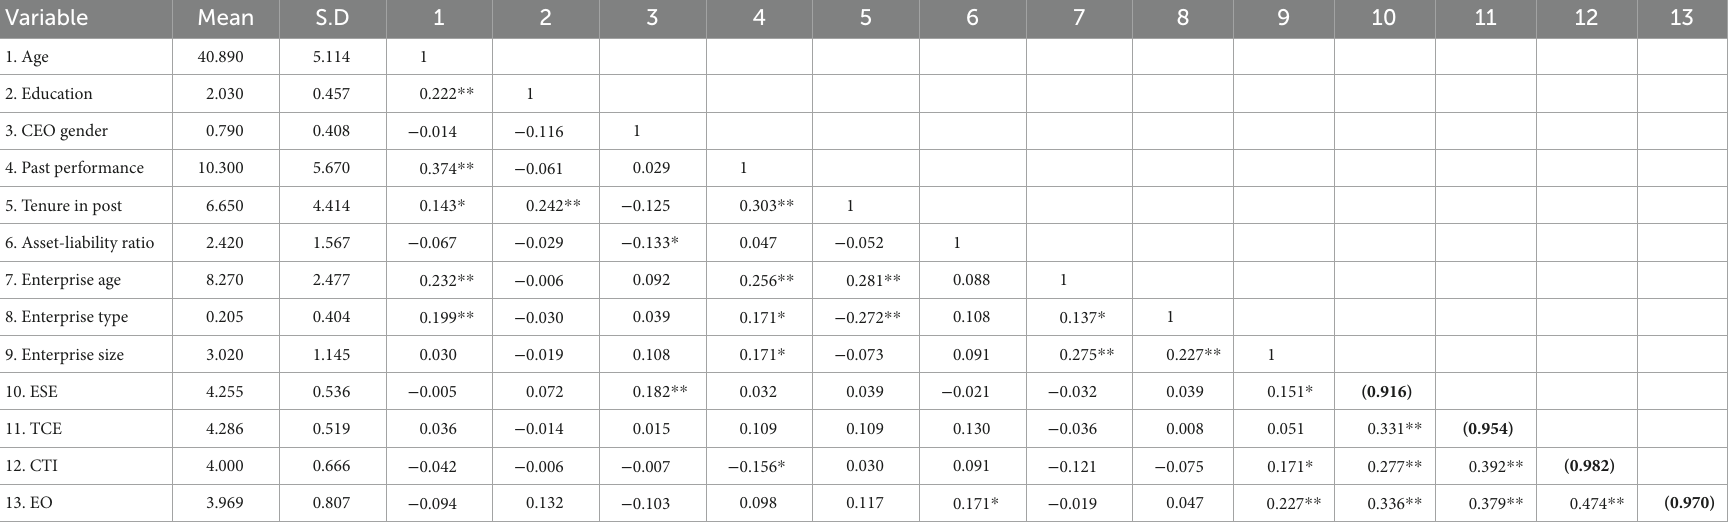
TABLE 3 Means, standard deviation, and bivariate correlations for all variables.